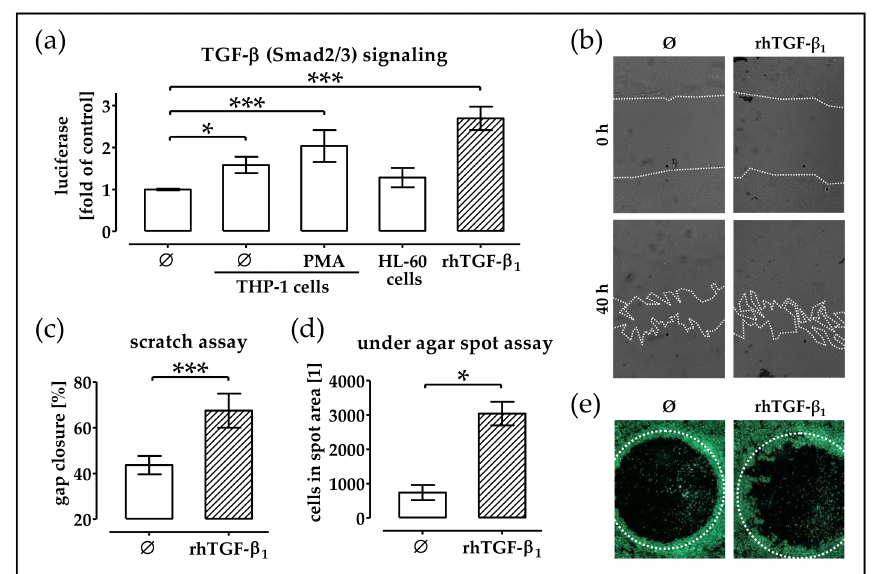
Figure 3. Conditioned medium from monocytic cells stimulates TGF- β (Smad2/3) signaling in phOBs. ( a ) phOBs ( N = 4, n = 3), infected with the Smad3/4 reporter adenovirus (Ad5-CAGA9-MLP-Luc), were stimulated with conditioned medium from THP-1 cells (representing monocytes), phorbol 12-myristate 13-acetate (PMA)-stimulated adherent THP-1 cells (representing macrophages), and dimethyl sulfoxide (DMSO)-stimulated HL-60 cells (representing granulocytes). In the presence of active TGF- β luciferase is expressed in the cytoplasm of the cells. After 48 h, the luciferase activity was measured with a microplate reader. ( b – e ) In order to investigate the influence of rhTGF- β 1 (5 ng/mL) on phOBs migration, a scratch assay and an under agar spot assay were performed. ( b ) Representative microscopic images for the scratch assay (20 × magnification). ( c ) Gap closure was determined from microscopic images (100 − gap area 40h /gap area 0h × 100) with the help of the ImageJ software. ( d ) For the under agar spot assay, the number of cells in the spot area was determined from microscopic images with the help of the ImageJ software. ( e ) Representative microscopic images for the under agar spot assay (12.5 × magnification). Cells were visualized with Calcein-AM stain for living cells. Data are represented in bar diagrams (mean ± 95% C.I.). * p < 0.05 and *** p < 0.001 as